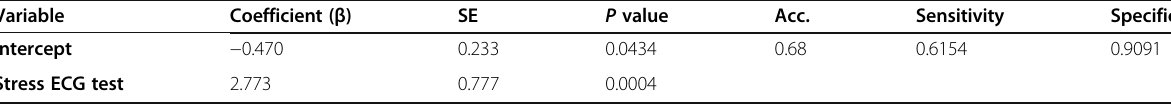
Acc accuracy, ECG electrocardiogram, SE standard